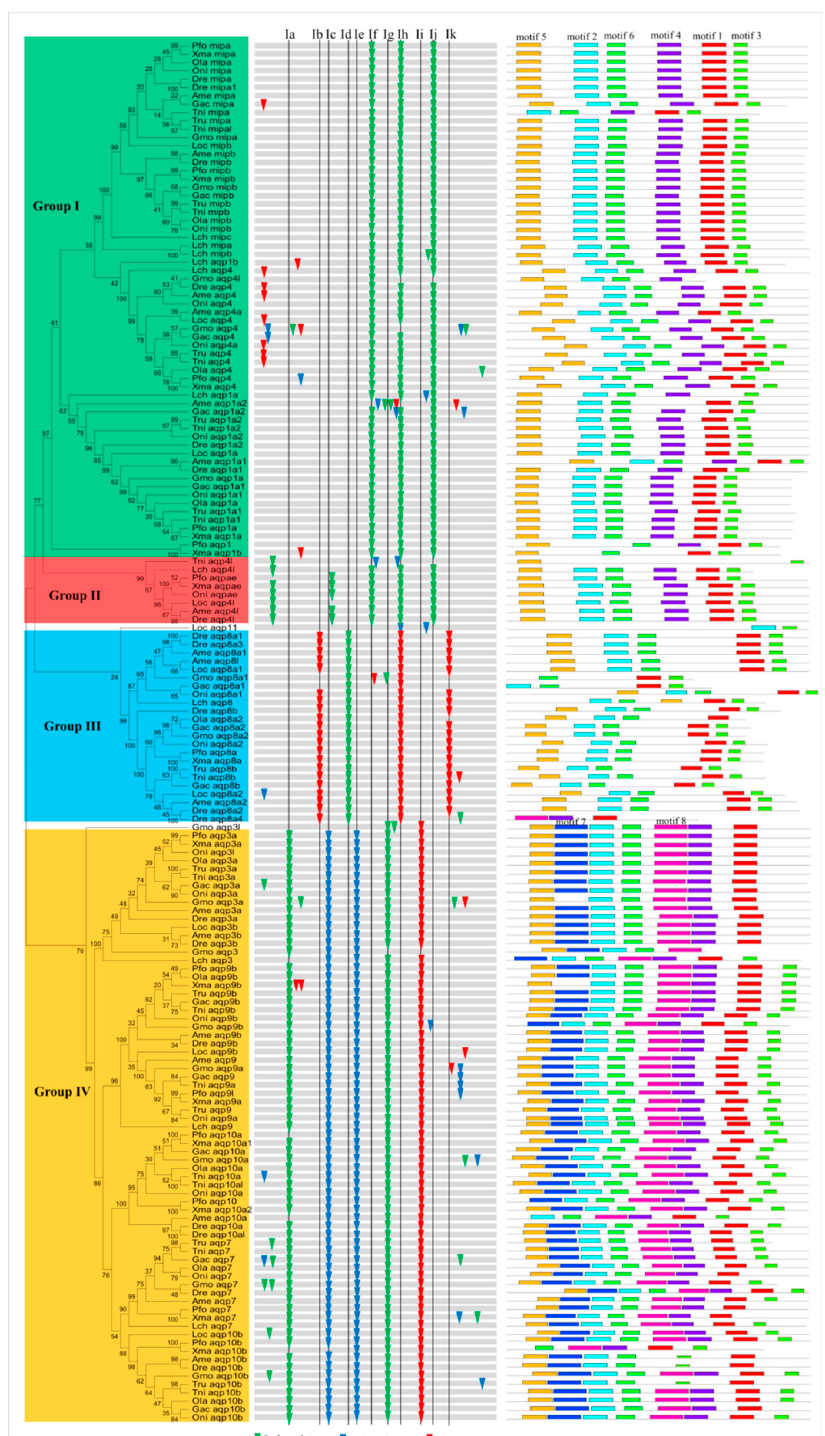
Figure 2. Phylogenetic relationship, gene structure, and motif composition of the Aqp genes in the twelve fishes. The phylogenetic tree was constructed and classified into four groups. Different motifs of the Aqp proteins are displayed by differently colored boxes. The abbreviation of species name is as follows, Poecilia formosa : Pfo; Xiphophorus maculatus : Xma; Gasterosteus aculeatus : Gac; Oreochromis niloticus : Oni; Oryzias latipes : Ola; Tetraodon nigroviridis : Tni; Takifugu rubripes : Tru; Gadus morhua : Gmo; Danio revio : Dre; Astyanax mexicanus : Ame; Lepisosteus oculatus : Loc; Latimeria chalumnae : Lch.